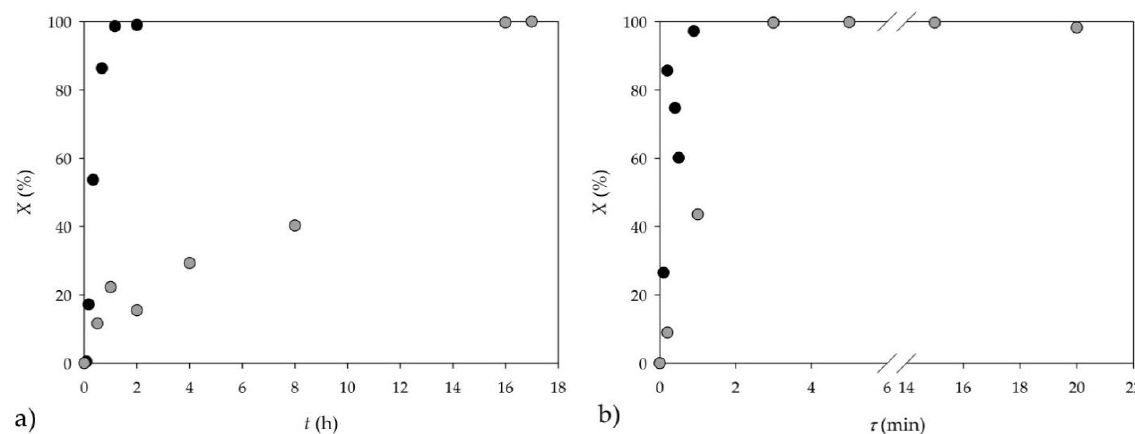
Figure 9. Comparison of the photocatalytic oxygenation process performed in ( a ) a batch reactor and ( b ) a winding channel geometry microflow reactor (• thienyl ( 1 ) and • furyl ( 2 ) as substrate).